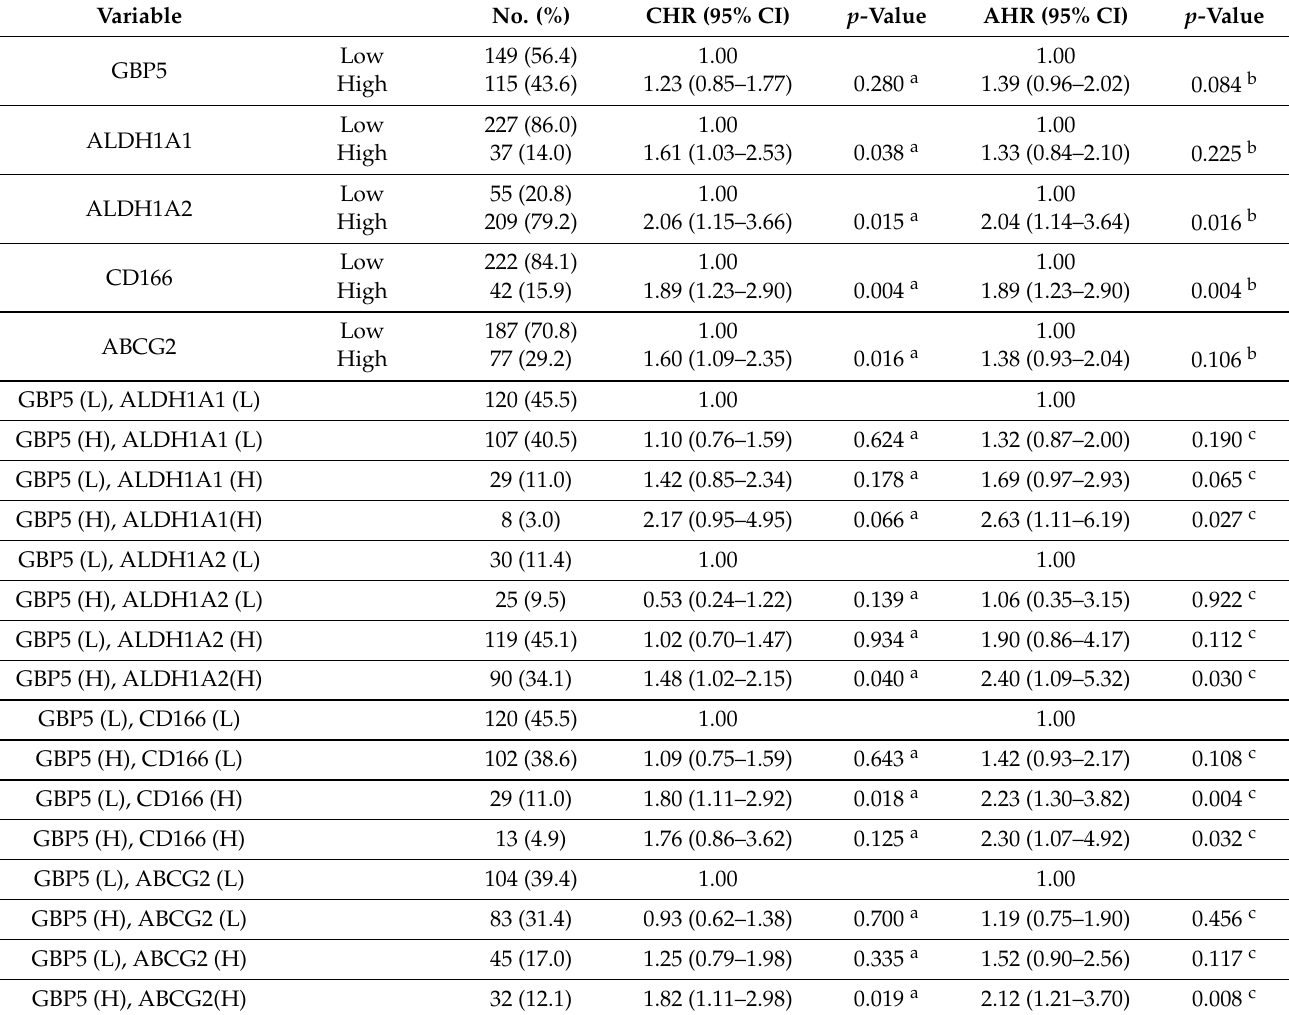
Table 4. The co-expression of GBP5 and cancer stemness markers in overall survival of oral cancer patients from TCGA database.